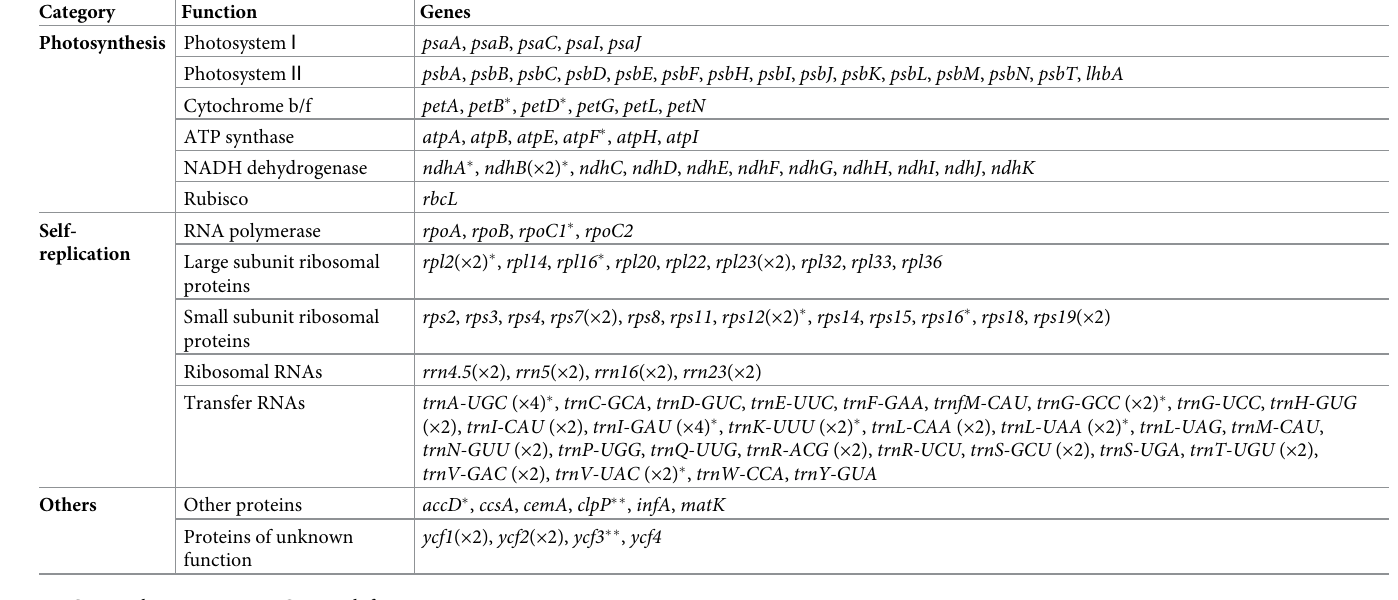
Table 2. Genes present in the chloroplast genomes of Z . montanum and Z . zerumbet . Category